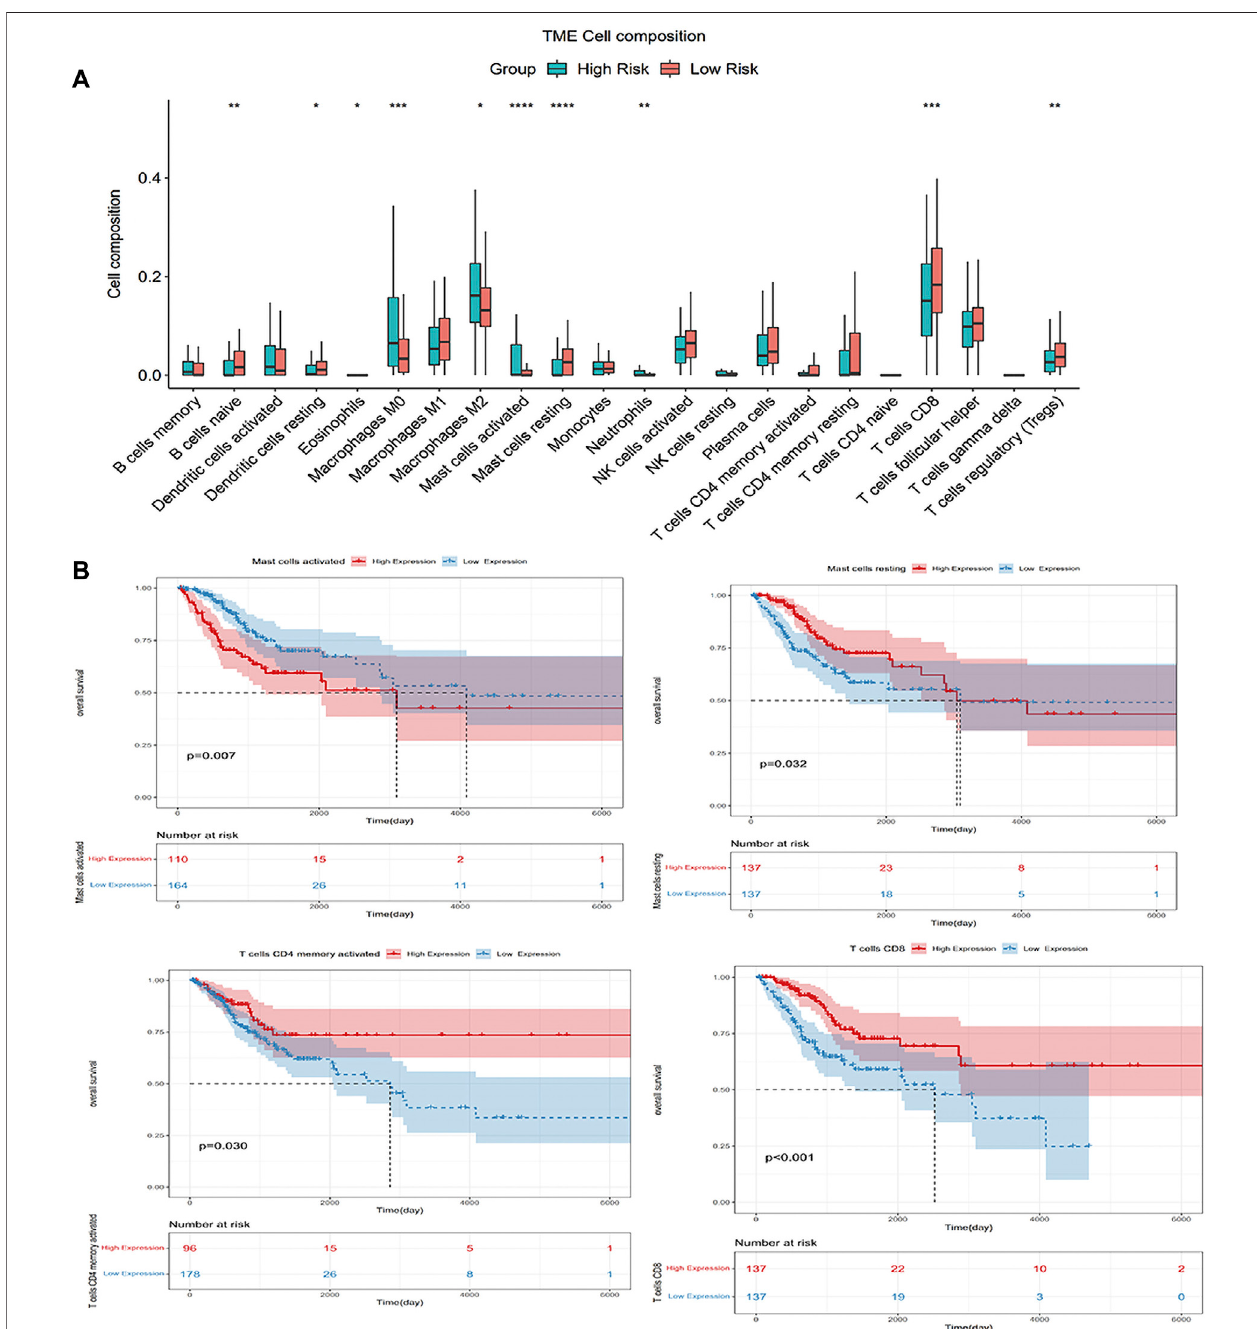
FIGURE 8 | (A) Wilcoxon rank-sum tests compared the difference and manifested that some immune cells had different in fi ltrating levels in two risk groups; (B) Kaplan – Meier analysis with OS for 22 immune